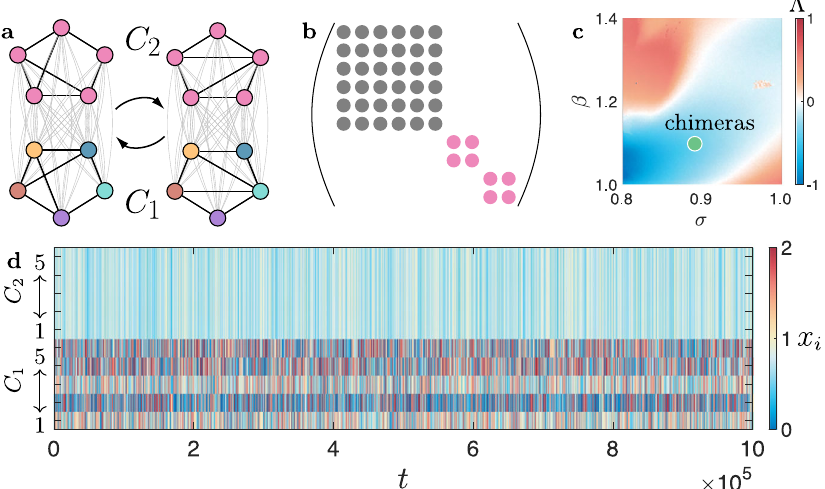
Fig. 4 Chimera states on a temporal network. a Two identical subnetworks of optoelectronic oscillators with strong intracluster connections (black lines) and weak intercluster connections (gray lines). The network structure switches back and forth between two different con fi gurations. The six dynamical clusters that form the chimera state are indicated by different node colors. b Common block structure of the matrices in the variational equation (4) under the SBD coordinates. The entries of the transformed matrices that are not required to be zero are represented by solid circles. The gray block corresponds to perturbations that do not affect the chimera stability, and the pink blocks represent transverse perturbations that determine the chimera stability. c Linear stability analysis of chimera states based on the SBD coordinates for a range of coupling strength σ and self-feedback strength β . Chimeras are stable when the maximum transverse Lyapunov exponent Λ is negative. d Chimera dynamics for σ = 0.9 and β = 1.1 (green dot in c ). Here, x i is the dynamical state of the i th oscillator, and the vertical axis indexes the oscillators in the respective subnetworks marked in a .